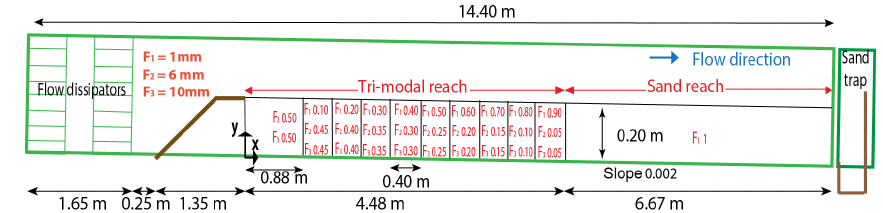
Figure 1. Flume setup and initial bed for Experiment T 1 . The red numbers indicate the volumetric gravel fraction content in each compart- ment.